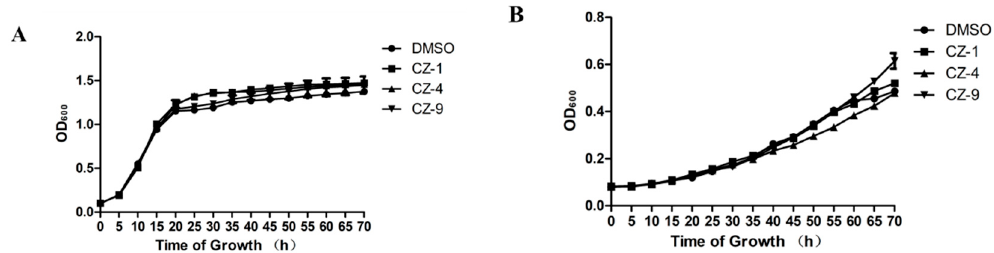
Figure 2. Growth rates of PXO99 A in rich medium M210 ( A ) and plant-mimicking medium XOM2 ( B ) supplemented with 200 μ M compounds. The optical density at 600 nm (OD 600 ) of the culture suspensions was measured every 1 h during a 72 h period. Three independent tests were